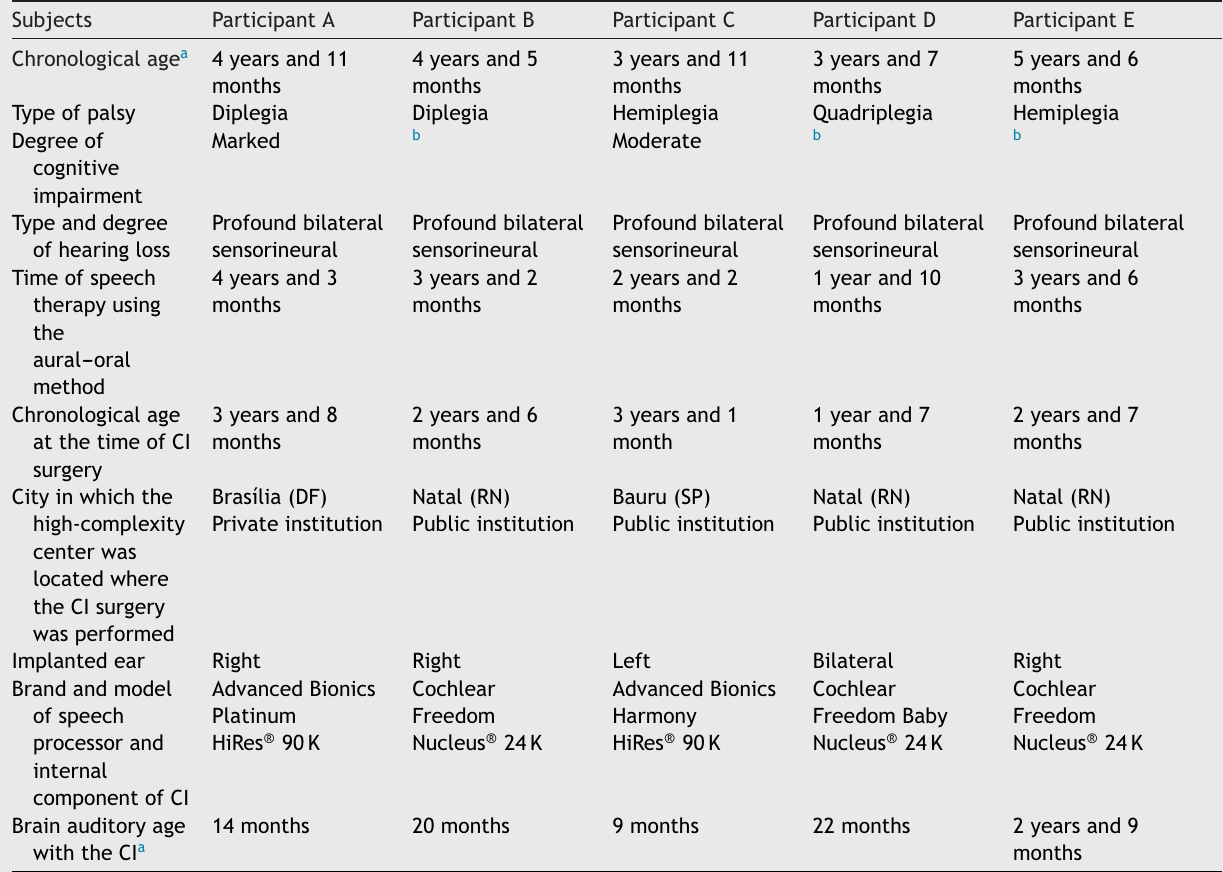
Characterization of the study